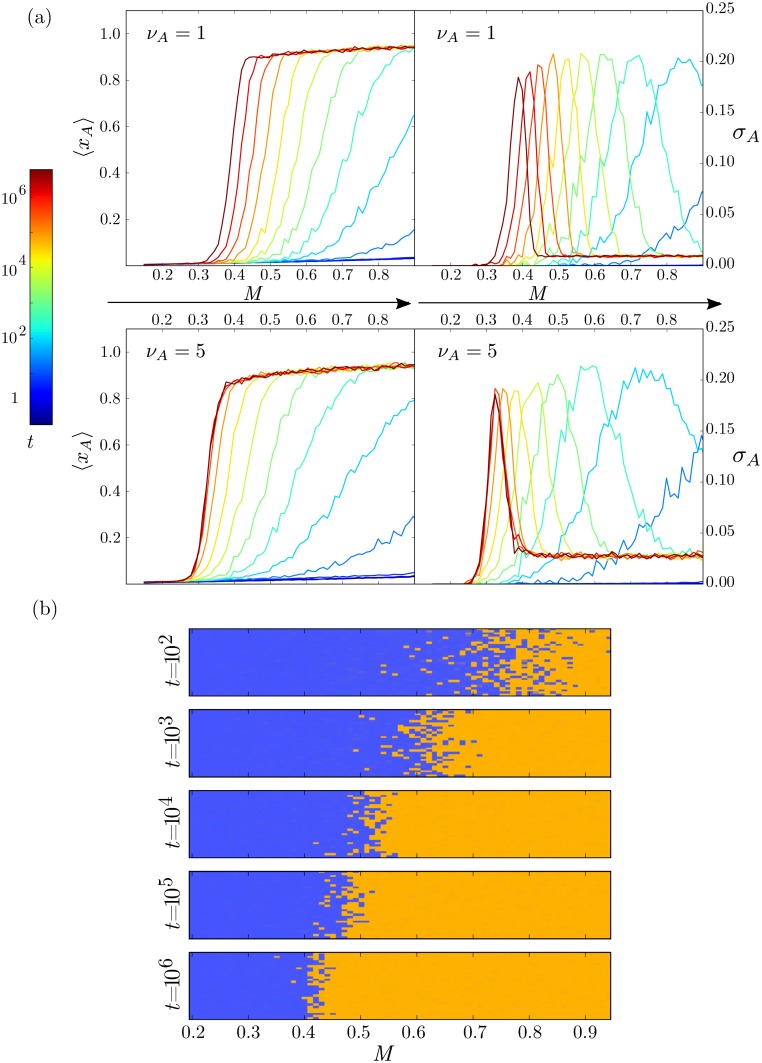
Switching events result in a travelling boundary with a speed depending on the stochastic parameters.(a) Mean and standard deviation of the expression of the morphogen activated gene A along the tissue at different time points for different burst sizes. Increasing the burst size makes the wave move faster but has a reduced impact on the precision of the boundary (see text for details). Results correspond to averaging of 500 trajectories with Ω = 120; the rest of the parameters are the same as in Fig 4. (b) Tissue simulations of the stochastic patterning process composed of 20 × 70 cells using trajectories from 7(a) top row (νA = 1). The colour of each cell is the RGB linear combination of blue and orange weighted with the expression states xA and xB. Individual cells are observed to have a decisive state, expressing one of the transcription factors at a much higher level than the other. The boundary is not perfectly sharp but the region containing both cell types narrows over time.